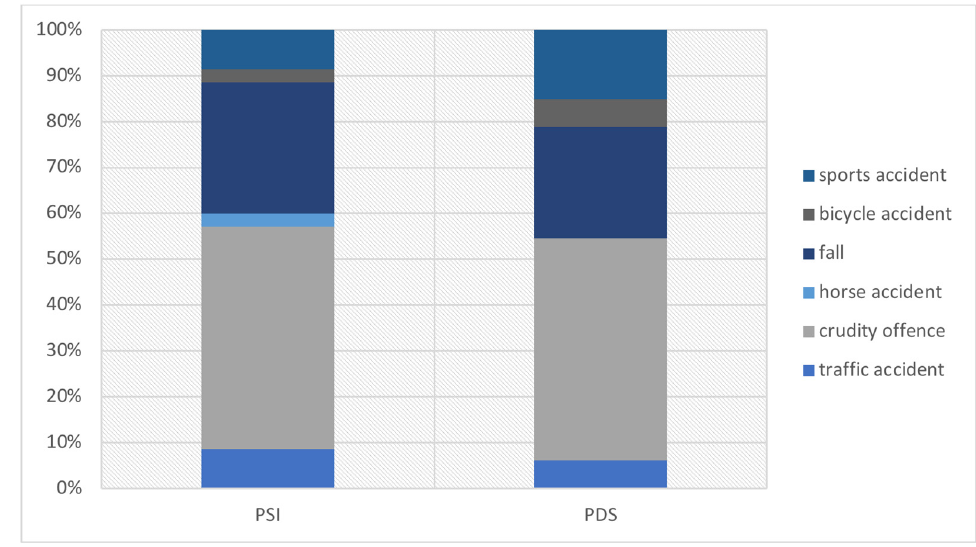
Figure 5. Trauma cause for orbital fractures differentiated by surgical treatment.